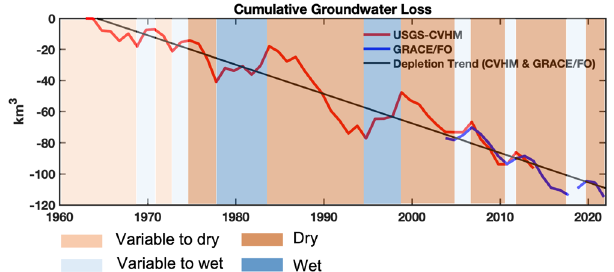
Fig. 4 | Yearly cumulative groundwater losses in the Central Valley. Ground- water losses combining the USGS ’ s Central Valley Hydrologic Model (CVHM) 13 and the GRACE/FO estimates since 1962. The black line represents the overall groundwater depletion from 1962 to 2021 calculated by combining the CVHM and GRACE estimates.